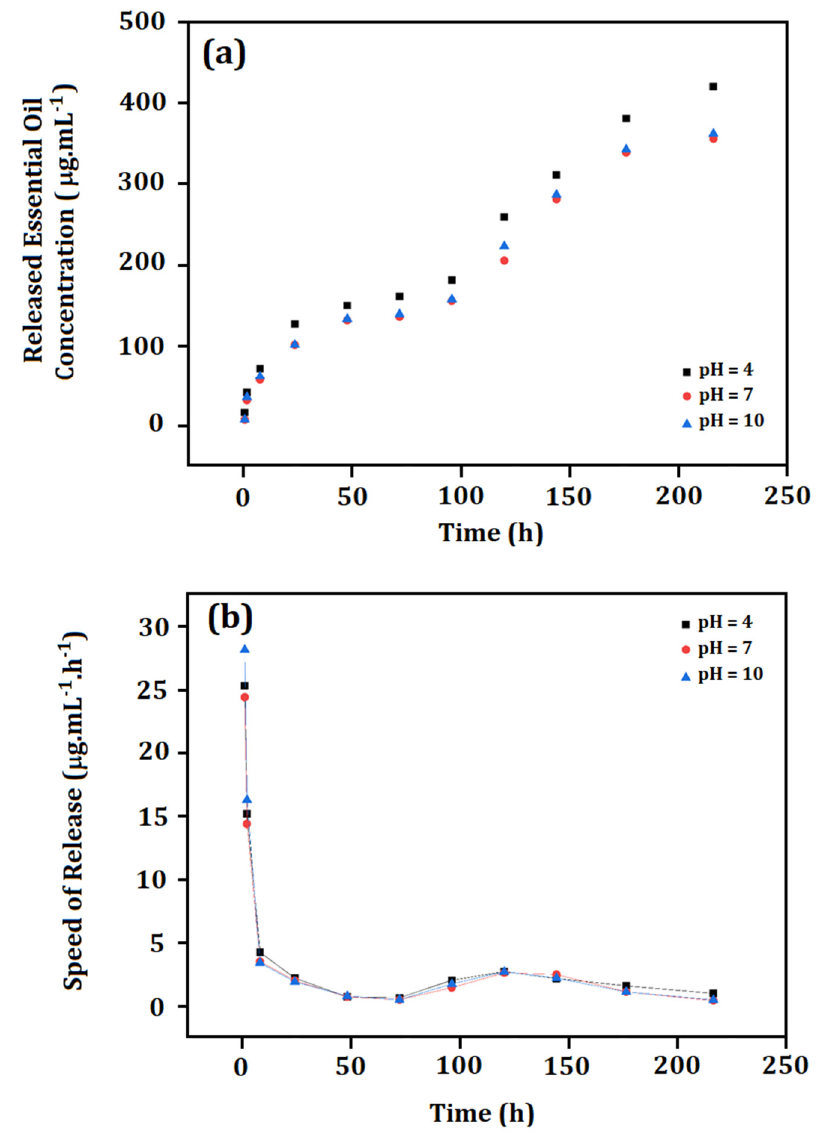
Figure 9. ( a ) Controlled release of essential oil at pH 4, 7, and 10, and ( b ) derived curve from the controlled release.